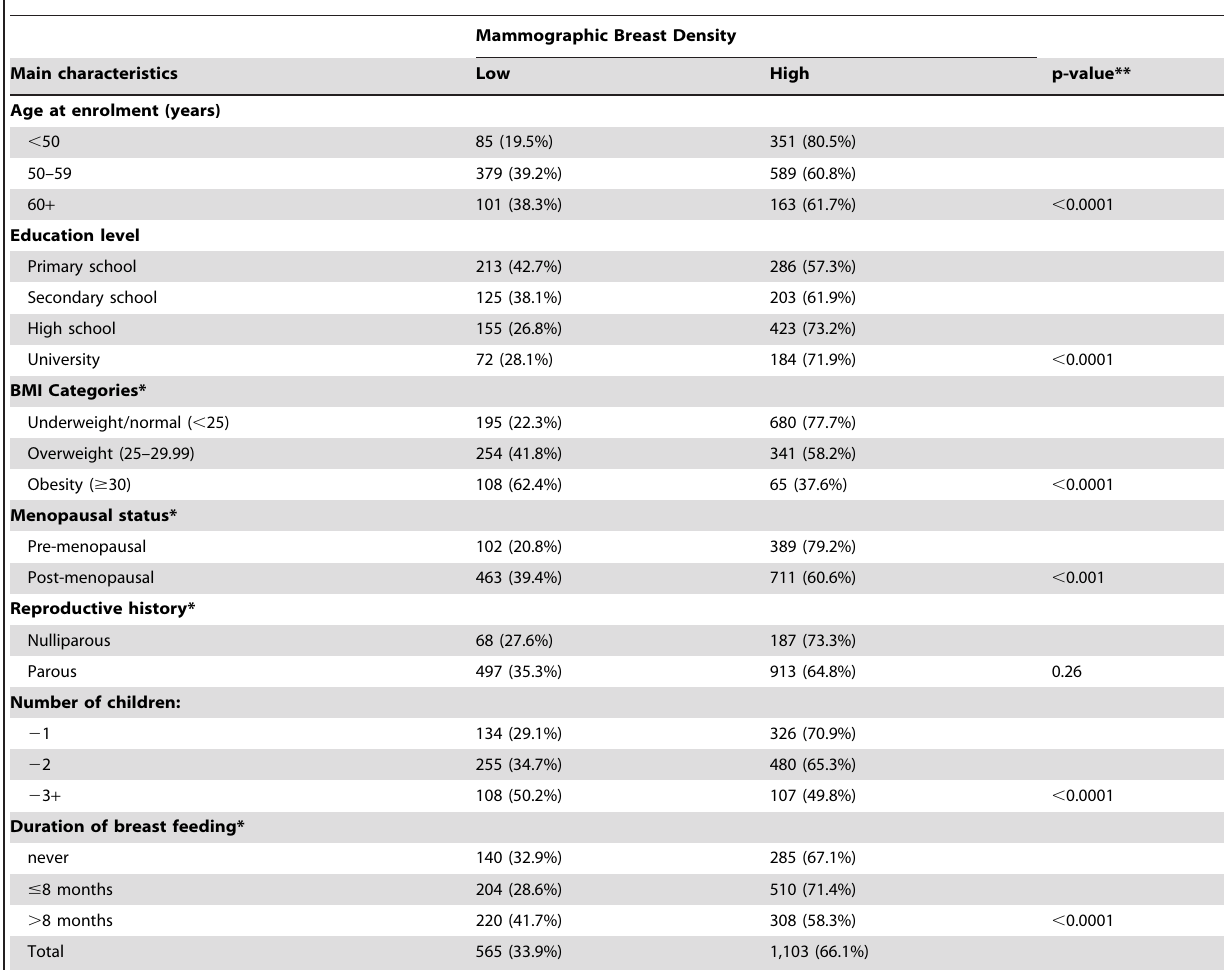
Table 1. Main characteristics of 1,668 participants by low and high MBD